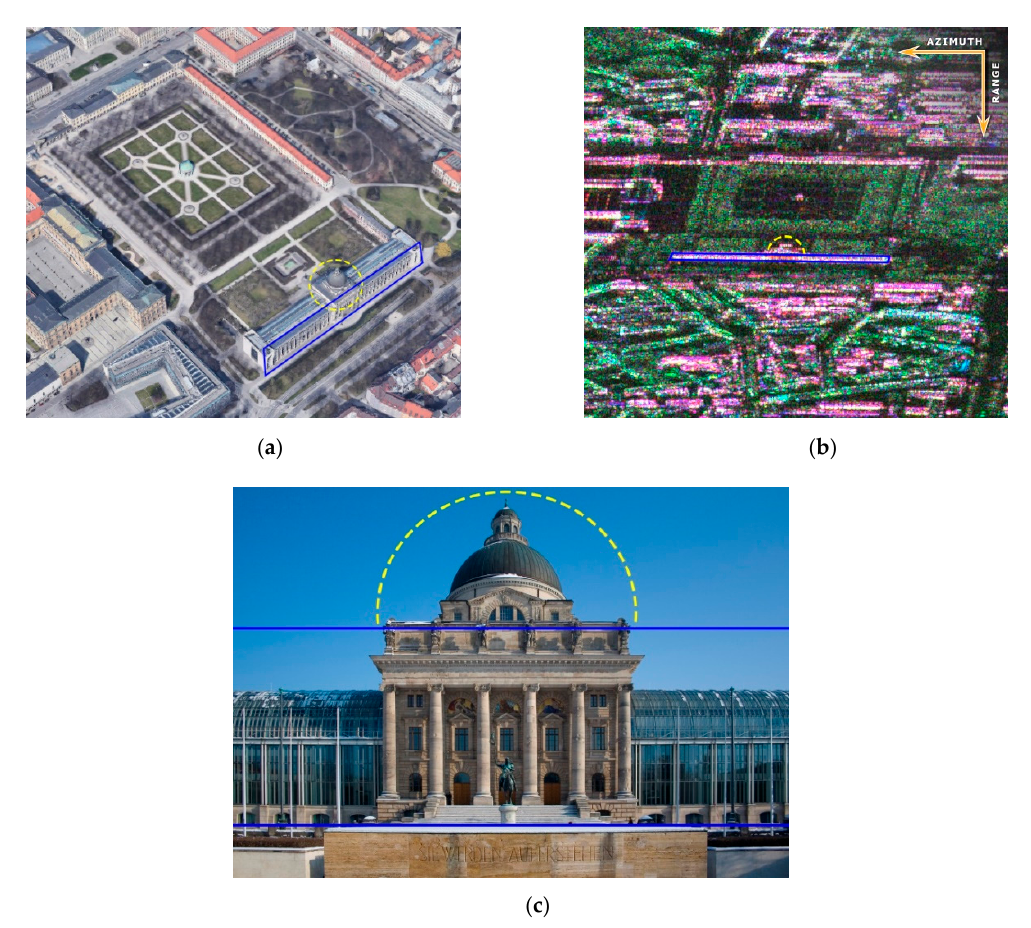
Figure 6. ( a ) Google Earth © image of the test region, where the building of the Bavarian state chancellery is located. ( b ) Polarimetric SLC SAR image of the test area [the colors correspond to the channels HH (red), VV (blue) and HV (green)]. ( c ) Front view of the edifice of the Bavarian state chancellery (Diego Delso, delso.photo, License CC-BY-SA).